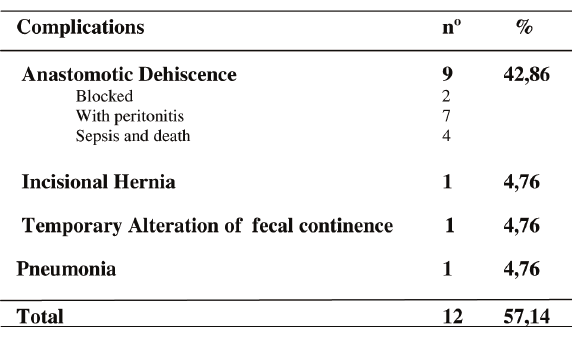
TABLE 7 – Surgical and clinical complications in 21 total